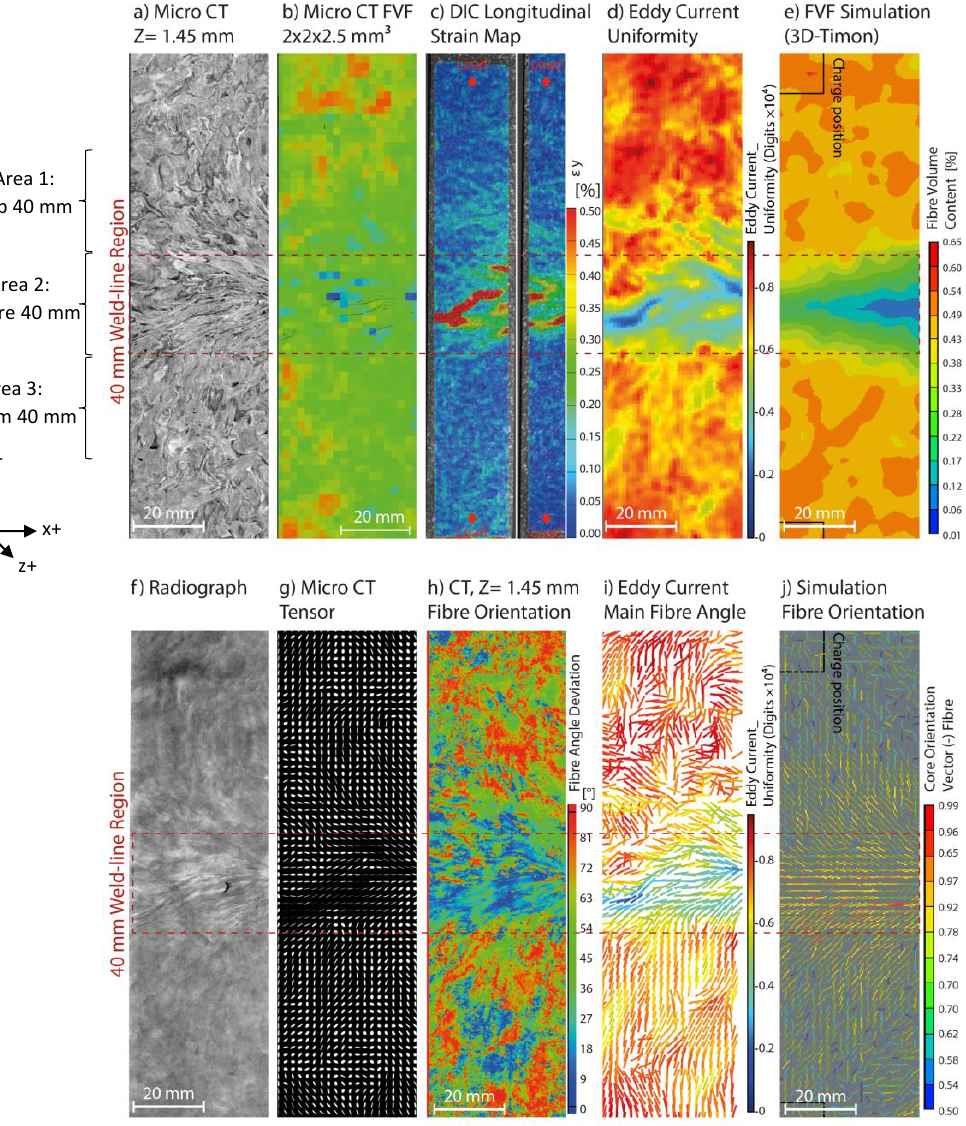
Figure 15. Comparing fibre angle and fibre volume fraction results for the Flow specimen, ( a ) micro CT image (at z = 1.48 mm), ( b ) micro-CT relative FVF, ( c ) DIC longitudinal strain map of two adjacent tensile coupons (max strain at 1%), ( d ) eddy current uniformity (fibre areal weight), ( e ) simulated fibre areal weight, ( f ) radiograph, ( g ) fibre tensors (micro-CT), ( h ) micro-CT fibre orientation (at z = 1.48 mm), ( i ) eddy current principal fibre angle, and ( j ) simulated fibre orientation. The WLD areas are highlighted with a red dashed box. Dimensions of area shown are 39 mm × 135